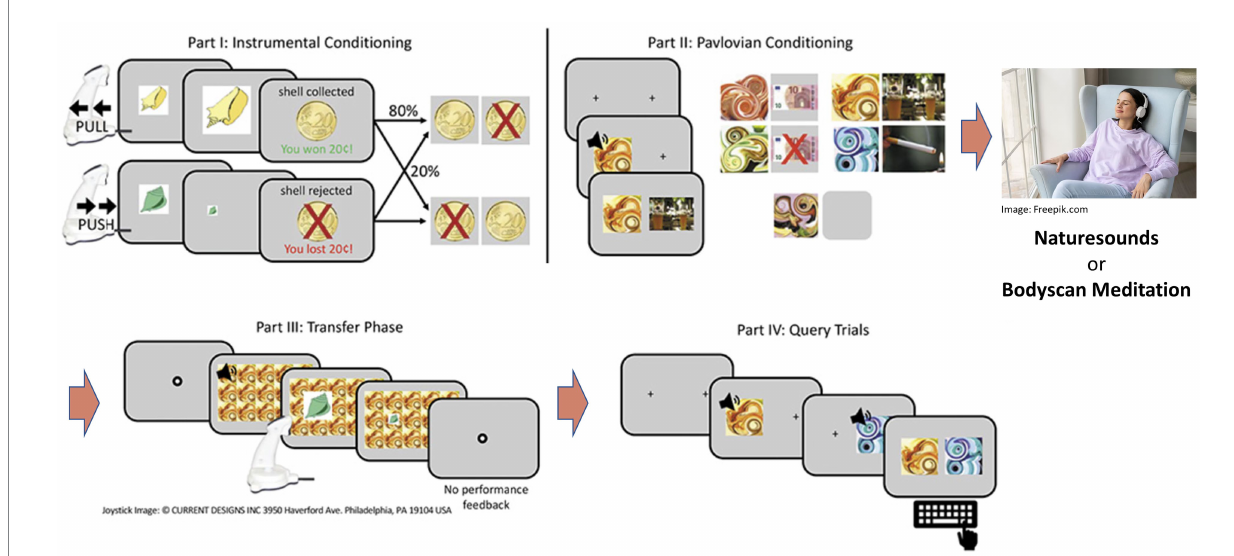
FIGURE 1 Schematic representation of the PIT procedure: In counterbalanced order, participants received a control intervention (nature sounds) or a mindfulness intervention (body scan) per experimental session. The intervention took place between Pavlovian conditioning and the actual transfer phase of the PIT task. Figure adapted from (29). The final, published version of this article is available at